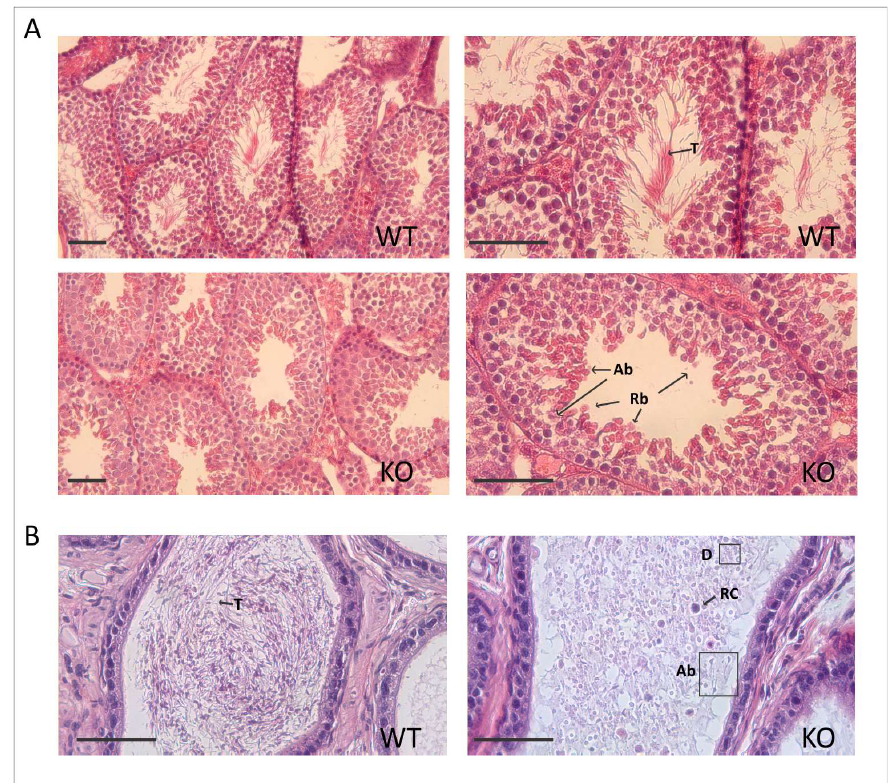
Figure 5 Figure 5. The Spag17 -deficient mice have severe defects in spermatogenesis. ( A ) Testis sections from knockout mice show major defects at spermatids stages 11–12. Abnormal head shapes of elongating spermatids are observed. Sperm tails are absent in the tubular lumen. ( B ) Cauda epididymis shows degenerated cell debris in the knockout epididymis. Indicated with black arrows and boxes: T, tail; Ab, abnormal; Rb, residual bodies; RC, round cells; D, debris. Scale bars = 100 µ m. 2.3. Spag17 Knockout Mice Display Defects in Manchette Structure and in the Morphology of the Sperm